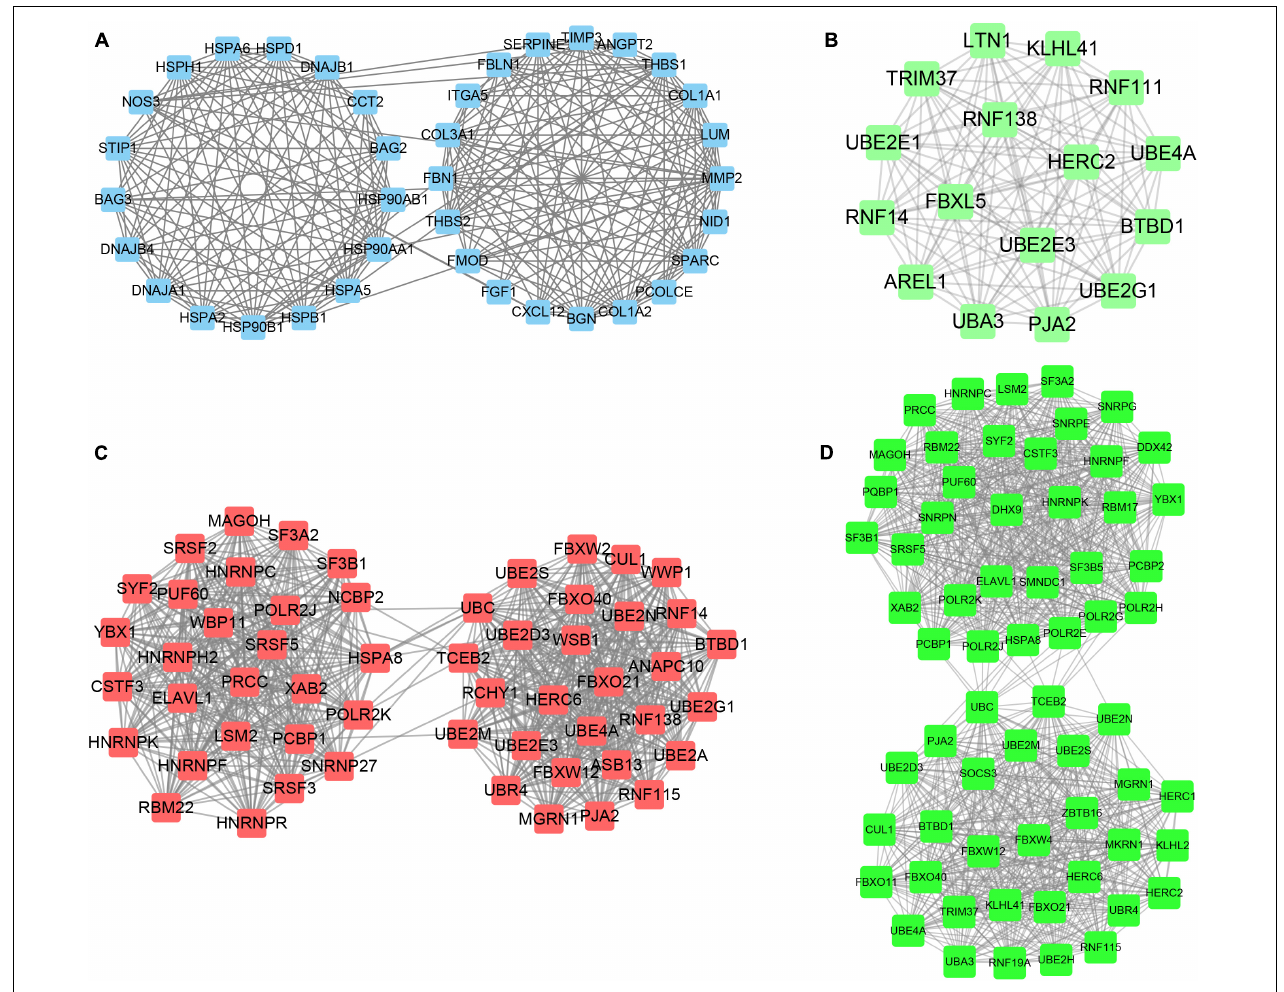
FIGURE 8 | Identification of hub networks in different clusters in MI. (A–D) We constructed hub networks based on DEGs in MI compared with non-failing controls (A), in cluster 1 MI compared with cluster 2 MI samples (B) , in cluster 1 MI compared with cluster 3 MI samples (C) , and in cluster 2 MI compared with cluster 3 MI samples (D)